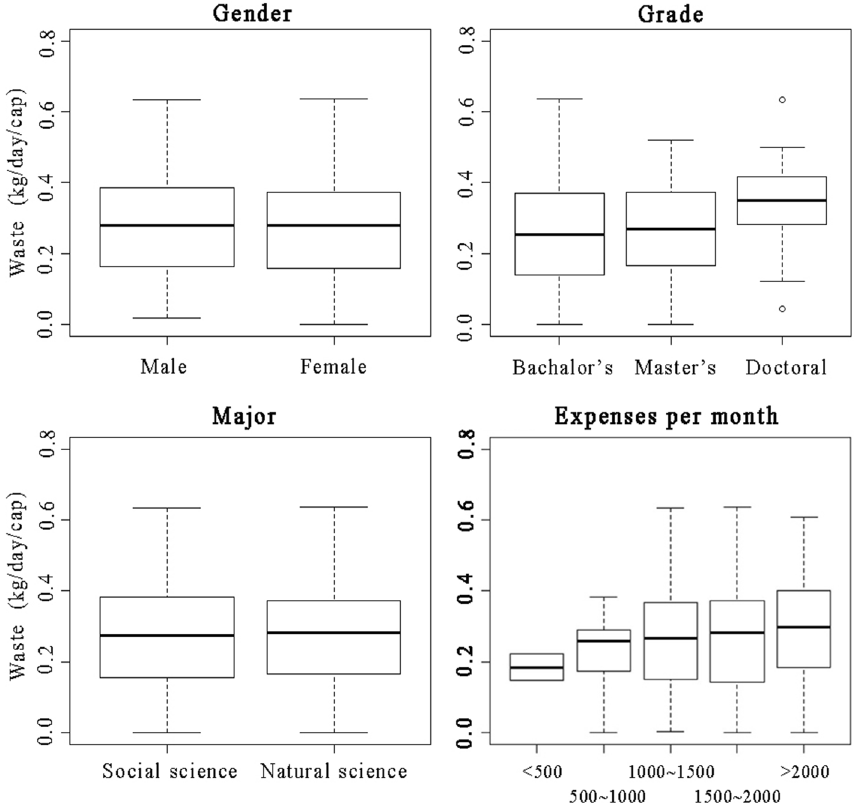
Figure 2. Descriptive results of personal attributes effect on waste generation. Note the bold and black line indicates the average waste generation of students of different gender, educational level, major and financial condition.